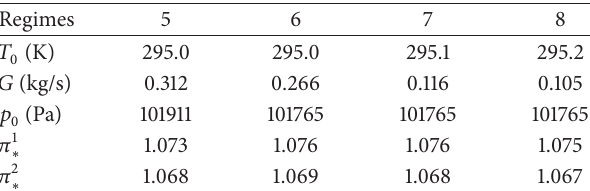
Table 2: Experimental data for regimes